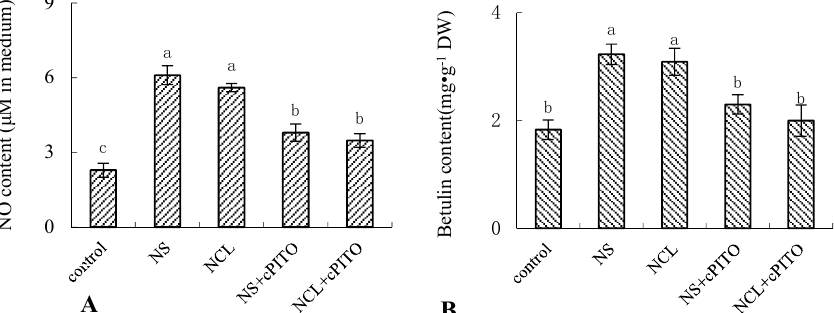
Figure 6. Effect of NH 4 + on the content of NO and betulin in suspension cells of birch. Eight-day-old suspension cells pretreated for 0.5 h with 150 µ mol · L − 1 2-(4-carboxyphenyl)-4,4,5,5-tetramethylimi-dazoline-1-oxyl-3-oxide (cPTIO) (NO-specific scavenger) were treated with 10 mmol · L − 1 (NH4) 2 SO 4 (NS) and 10 mmol · L − 1 NH 4 Cl (NCL) for 12 h, respectively. ( A ), NO content in culture medium of birch; ( B ), betulin content in suspension cells of birch.